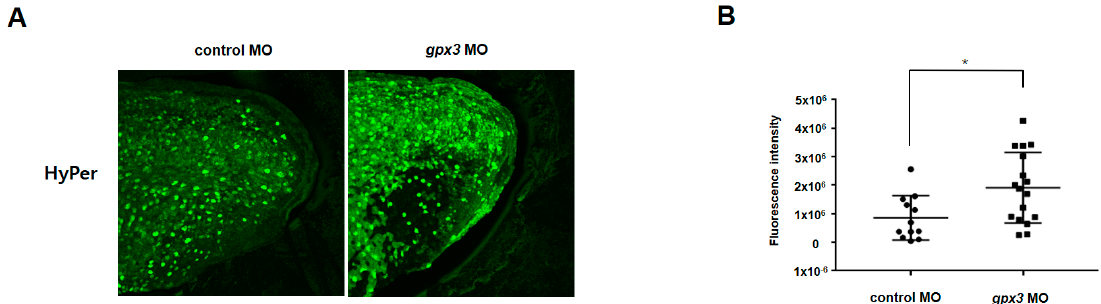
Figure 3. Perturbed gpx3 leads to increased reactive oxygen species (ROS) levels. Embryos were injected with 10 ng of HyPer mRNA at the 1-cell stage. MOs were injected into the ventral regions at the 4-cell stage. ( A ) gpx3 MO-injected embryos show increased HyPer fluorescent compared to the control. ( B ) HyPer fluorescence intensity quantification using ImageJ. * p < 0.05.